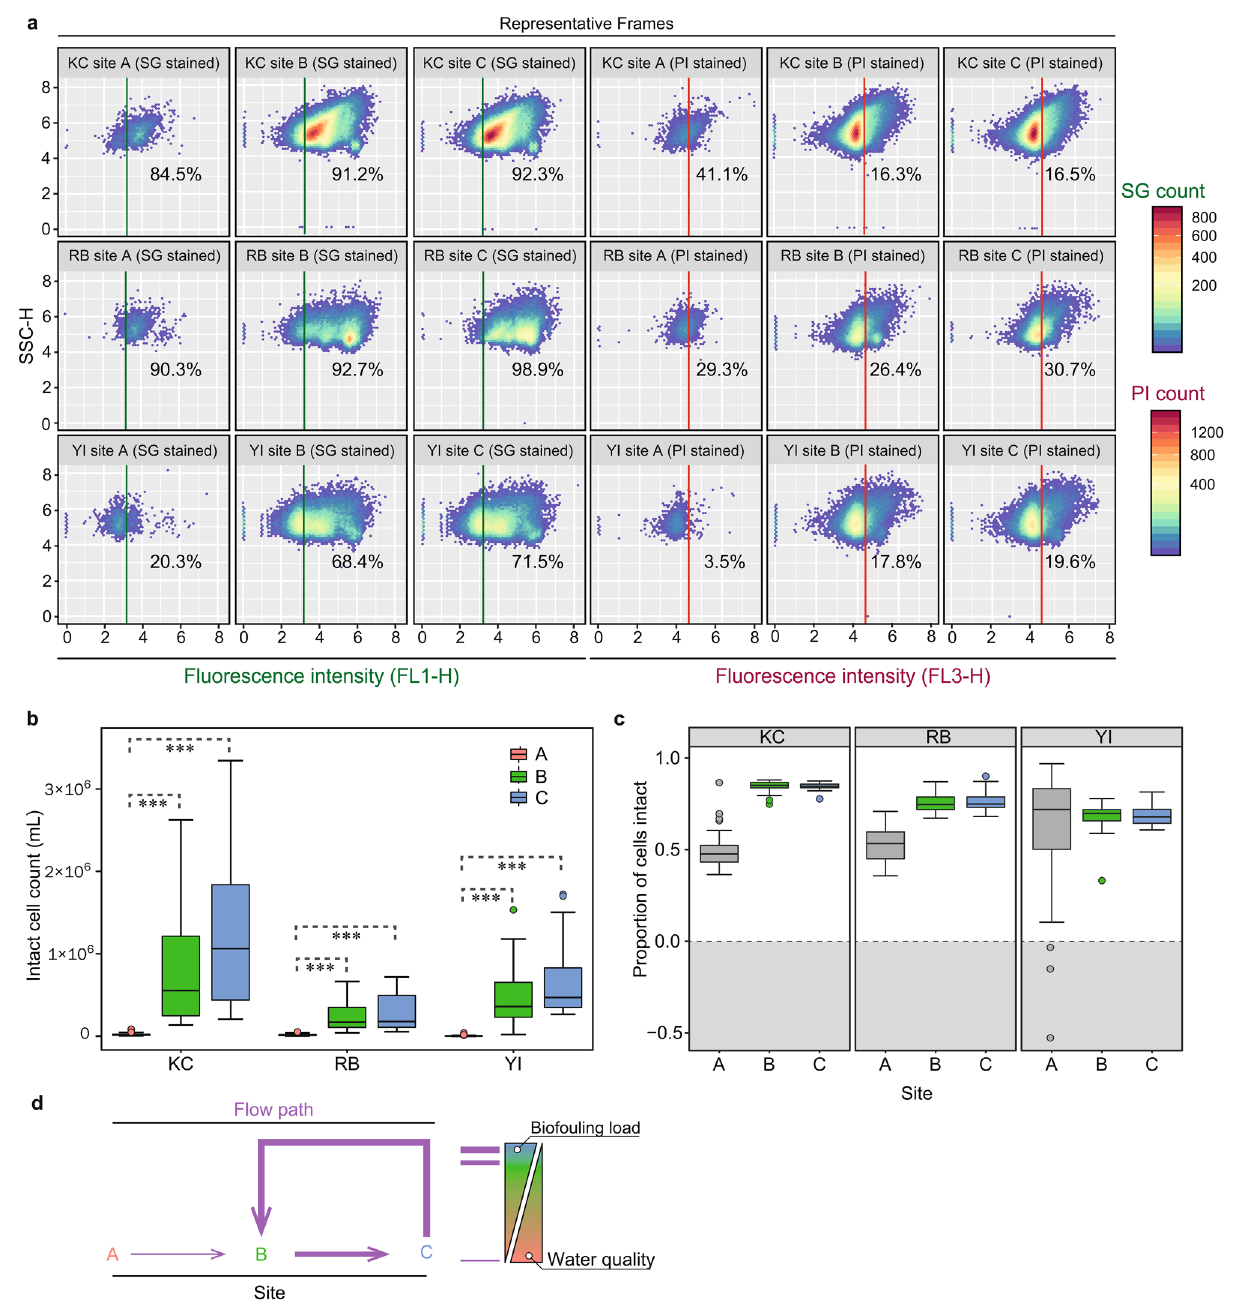
Figure 3. Microbes enter the system at the environment exposed WCT basins and persist in the condenser loop. a —representative frames from samples taken in the first day, to highlight typical gating results from each sample group across the 1244 flow frames generated in this study. b —Summary boxplot of intact cell counts (per mL) for all samples from each plant and site group. Box boundaries represent the 25th (lower) and 75th (upper) percentiles (Q1 and Q3 respectively), upper whiskers show Q1—1.5 × interquartile range (IQR), lower whiskers show Q3 + 1.5 × IQR, data beyond those ranges are shown as individual points. Asterisks represent significant differences between comparisons (grey dashed line) where ***— P < 0.001. c —Summary boxplot showing the proportion of living cells found at each site. Here, A site boxes are greyed out as the counts were below the limit of detection (as evidenced by the negative values obtained (grey area) when calculating these values. d — Conceptual model of the flow path as it relates to the microbial load and water quality highlighting results from computational gating across the cytometric dataset , i.e. that microbial ingress into the system occurs at the WCT basins persist in the condenser loop waters (site C) and are reintroduced back into the basin, where they can further contribute to